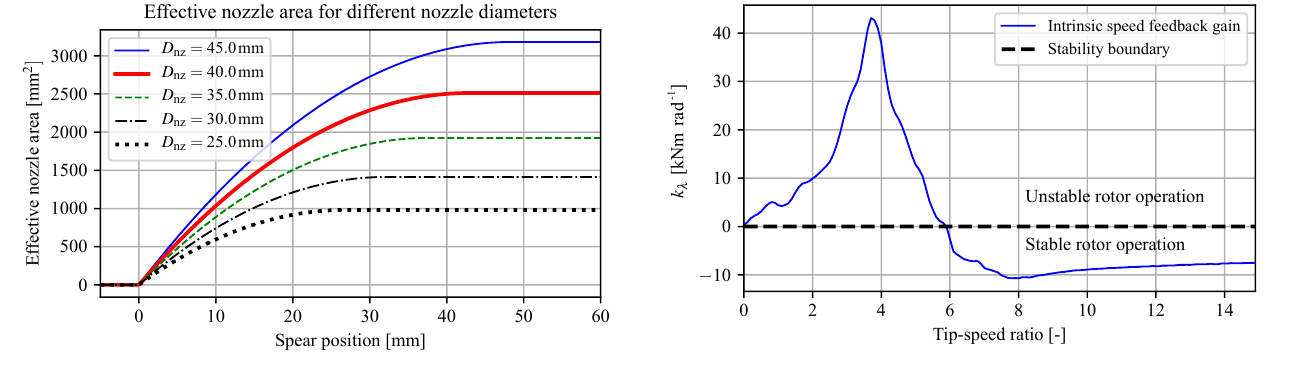
Figure 10. The intrinsic speed feedback gain k λ ( λ,β,U ) as a func- tion of tip-speed ratio λ at a fixed pitch angle and wind speed of − 2 ◦ and 8ms − 1 . Stable turbine operation is attained for nonposi- tive values of k λ